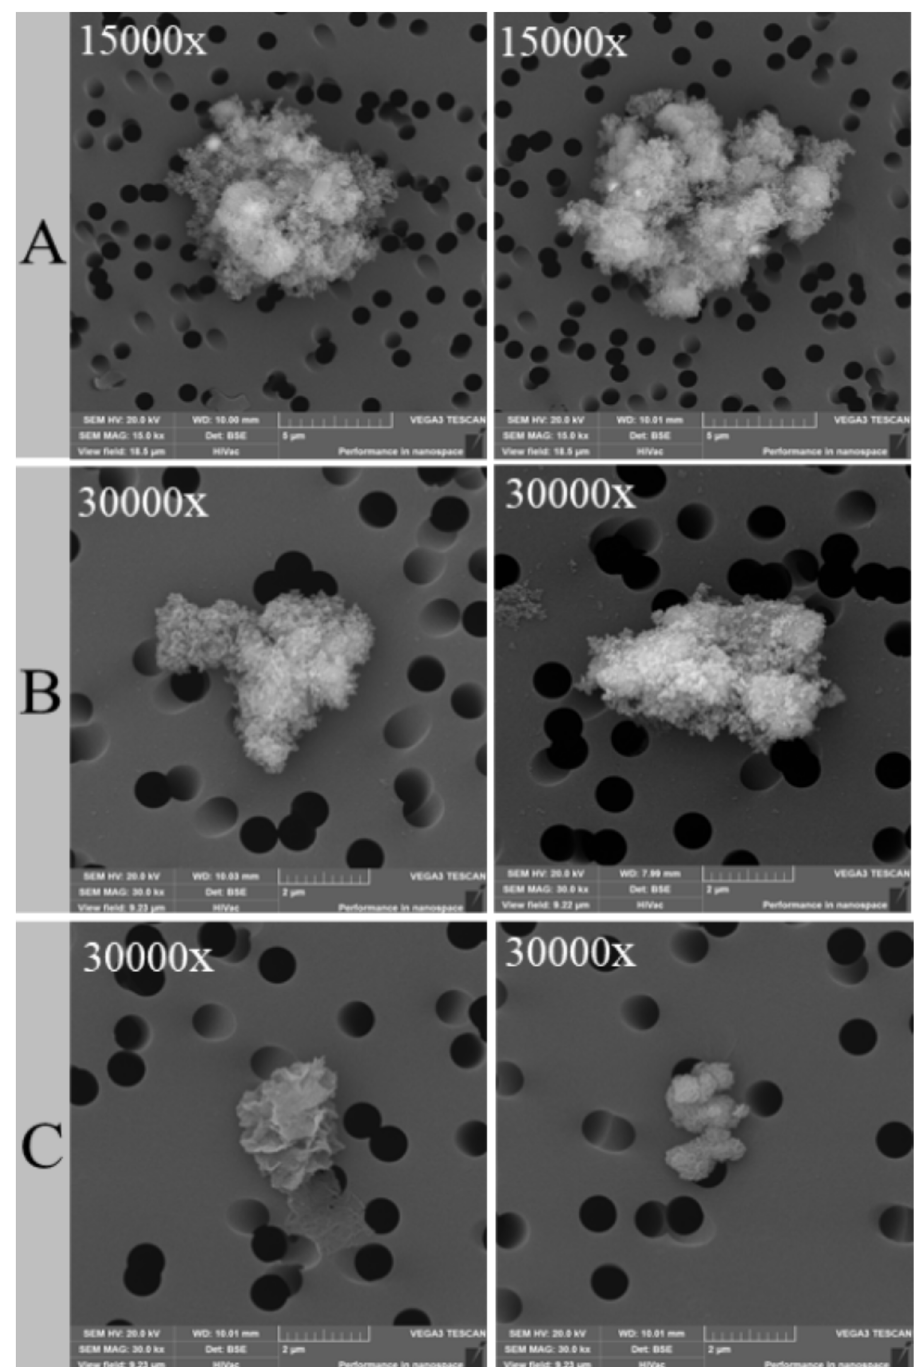
Figure 2. SEM microphotographs of the three grain-size fractions ( < 10 μ m, < 3 μ m and < 2 μ m), referred to as ( A – C ), respectively. Powder particles were obtained from SHS-treated waste to be tested in A549 and Raw 267.4 cell